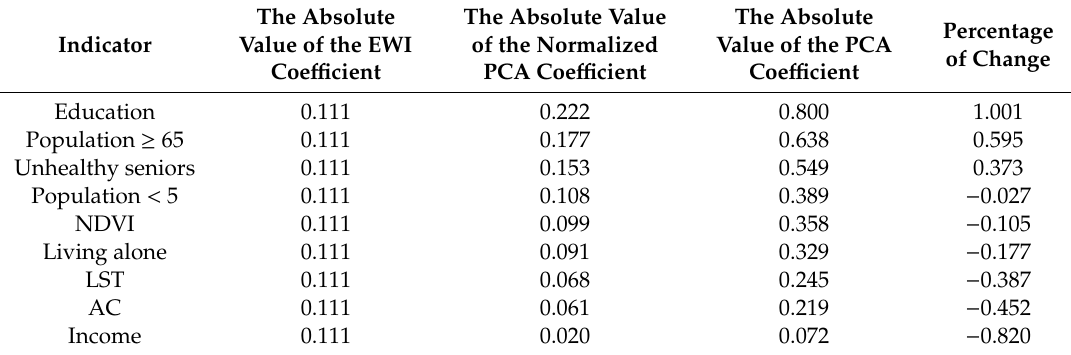
Table 6. Comparison of coe ffi cients between principal component analysis (PCA) and equal-weighted index (EWI)